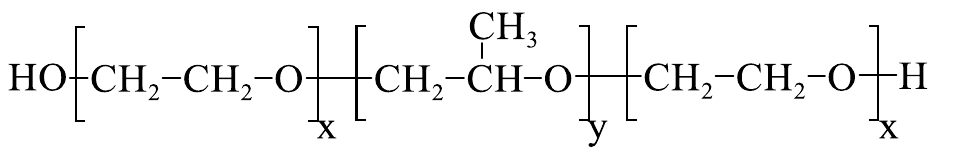
Figure 2. Poloxamer formula: X and Y represent Poly (ethylene oxide) (PEO) and Poly (propylene oxide) (PPO), respectively: Length of PEO and PPO chains. The image has been taken from the publication by Russo et al. [11] with permission.